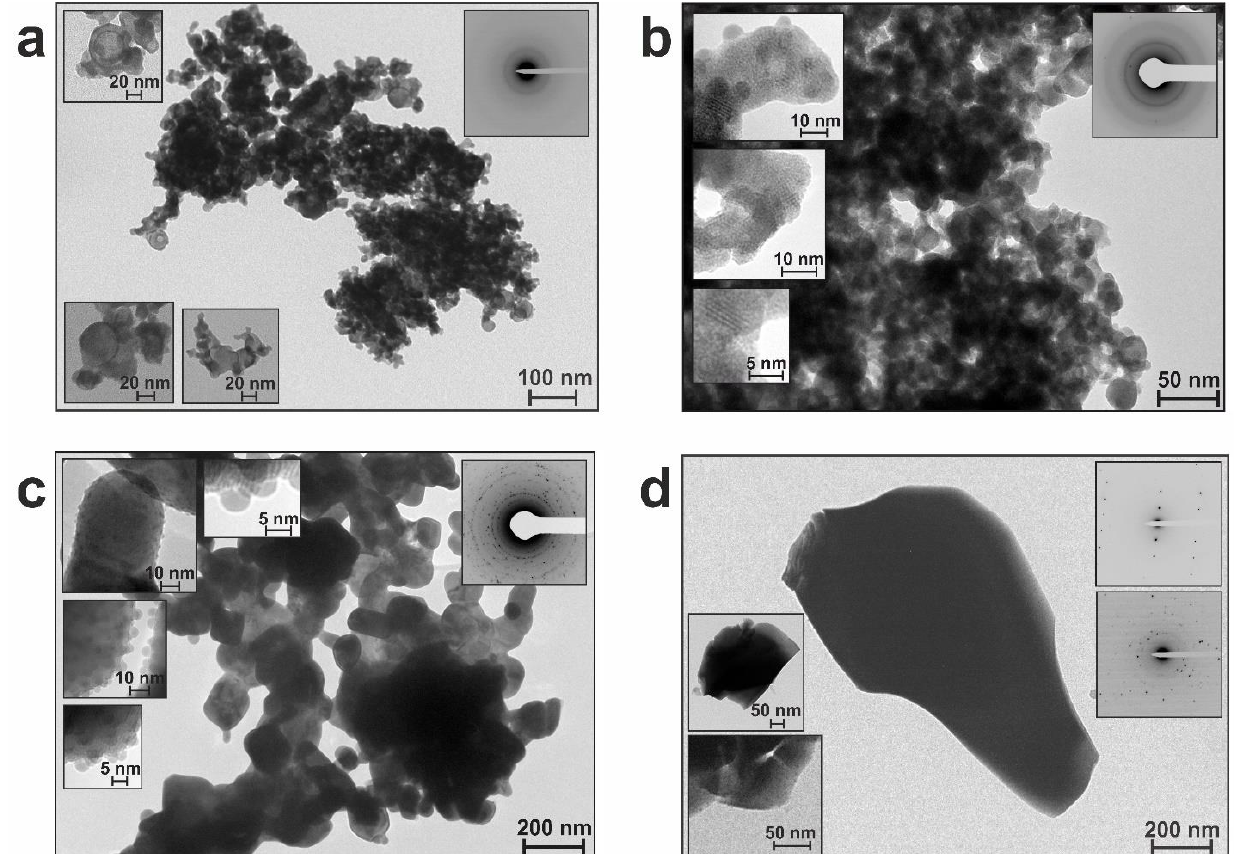
Figure 10. TEM images of selected samples from the BSO_hν group: ( a ) BSO_hν_3, ( b ) BSO_hν_4, ( c ) BSO_hν_6, and ( d ) BSO_hν_8 annea led at 300, 400, 600 and 800 °C, respectively.